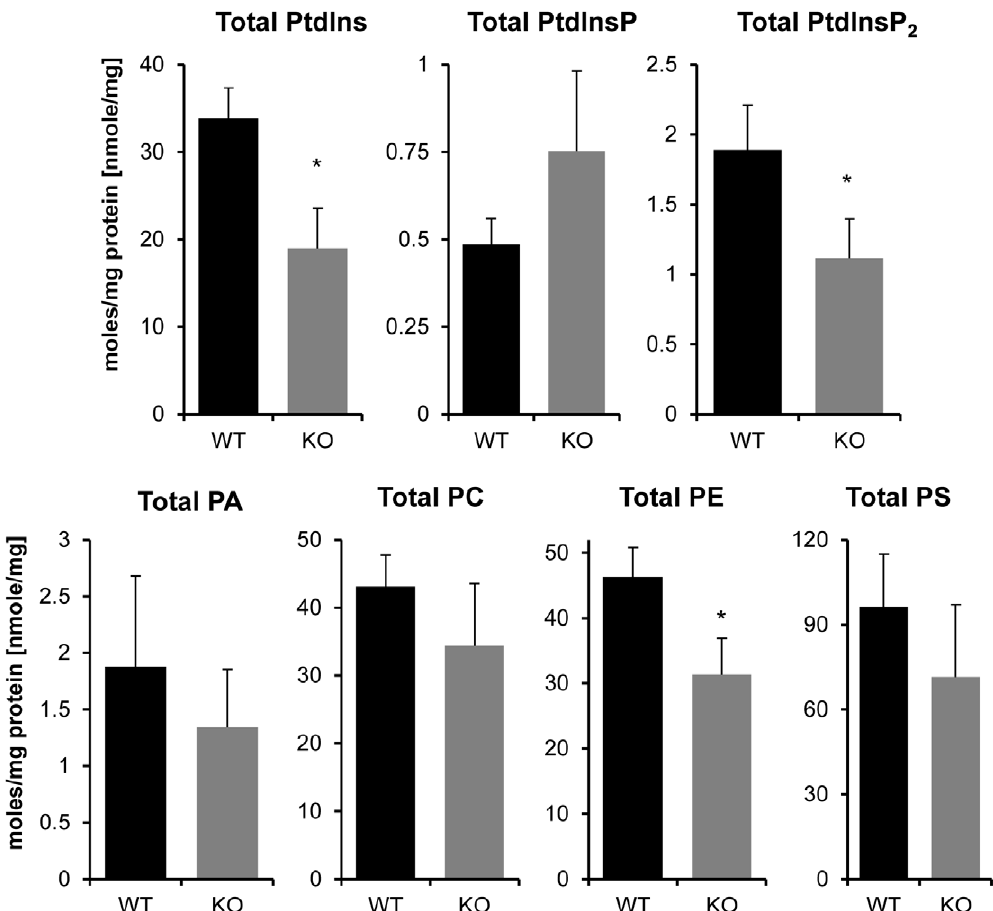
Figure 7. Effect of LPIAT1 knockout on total levels of brain phospholipids and phosphoinositides. Quantitated targetted molecular species of phosphoinositides PtdIns, PtdInsP and PtdInsP 2 in LPIAT1 + / + (WT) or LPIAT1 2 / 2 (KO) brain samples presented in Figure 6, and phospholipids PA,PC,PE and PS from Figure 5 were added to calculate total levels for each lipid. Data are mean 6 SD, n=4 for both WT and KO. *p # 0.05, **p # 0.005, T-test.